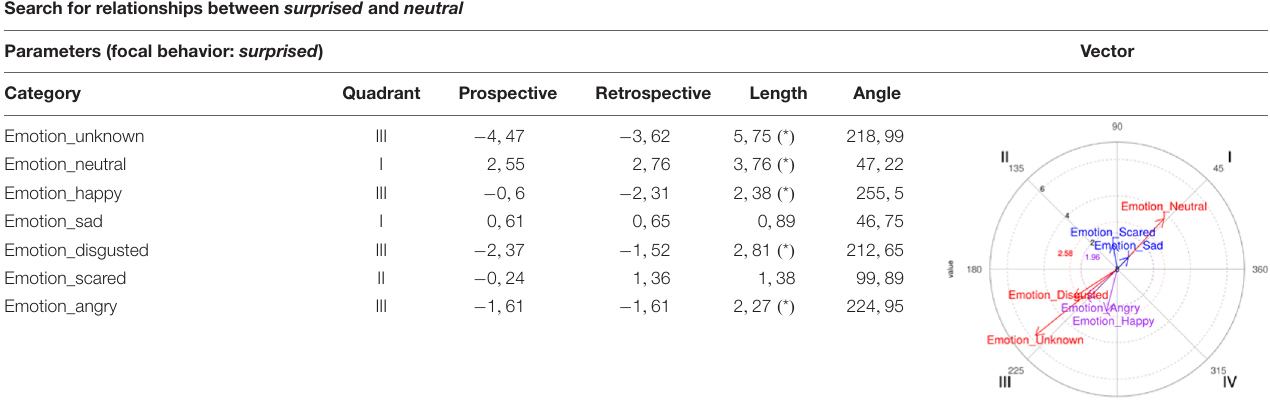
TABLE 2 | Polar coordinate analysis focusing on surprised / neutral and neutral / surprised relationships, corresponding to the girls’ records. Search for relationships between surprised and neutral Parameters (focal behavior: surprised ) Vector Category Quadrant